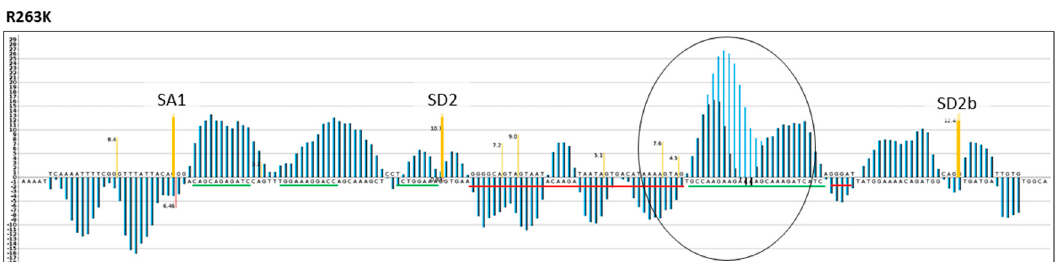
Figure 1. Organization and regulation of the HIV-1 genome: ( A ) the positions of the HIV-1 open reading frames are shown as grey boxes. Ribosomal frame-shifting allows the production of the viral enzymes protease (PR), reverse transcriptase (RT), and integrase (IN), which are also cleavage products of the Gag-Pol polyprotein. The 288 amino acids (32kDa) HIV-1 IN mediates the